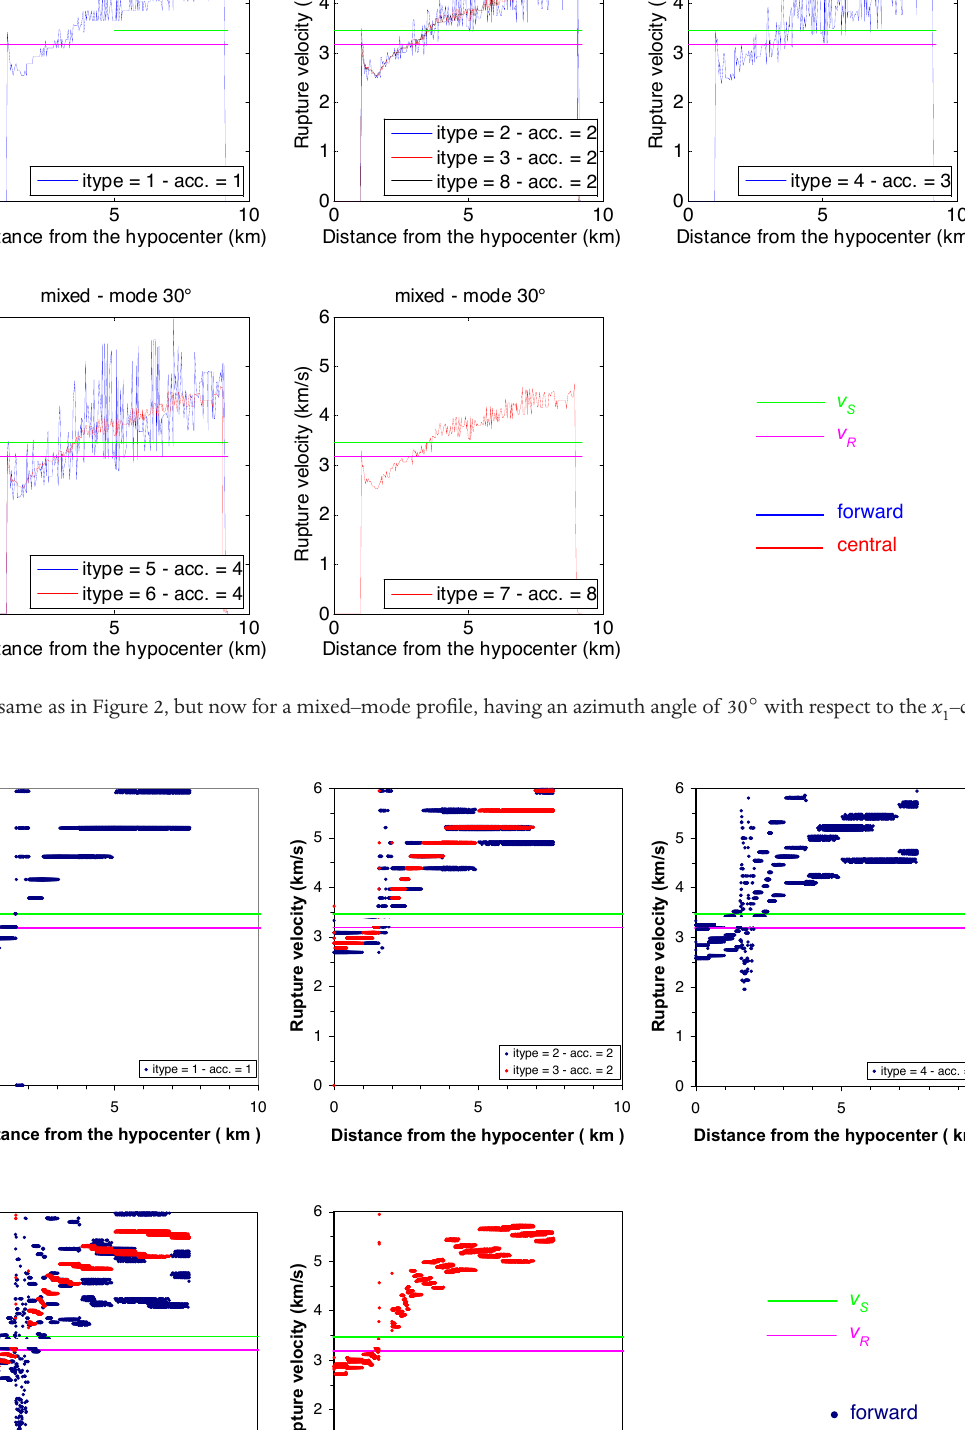
Figure 6. The same as in Figure 2, but now for a 2–D, purely mode II rupture. Due to the 2–D nature of the rupture we are able to compute only the schemes 1 to 7 of Table 2. The nearly vertical clouds of points appearing at about 2 km from the imposed hypocenter are numeri- cal noise, due to the jump of the rupture front occurring in